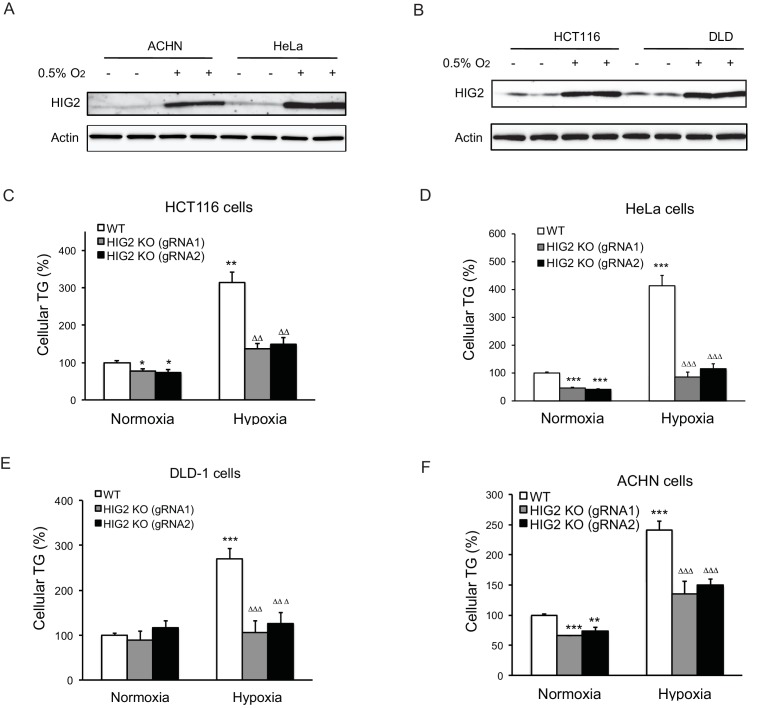
Enhancement of lipolysis reduces TG accumulation under hypoxia.(A, B) HIG2 expression by immunoblotting after 24 hr of incubation under normoxia or hypoxia. (C–F) Two HIG2 deficient clones in four cell lines indicated were generated with two independent gRNA specific to HIG2 by CRISPY/Cas9 method. Cellular TG contents were measured after 24 hr of incubation under normoxia or hypoxia. n = 3 biologically independent experiments for (C); n = 4 biologically independent experiments for (D–F).